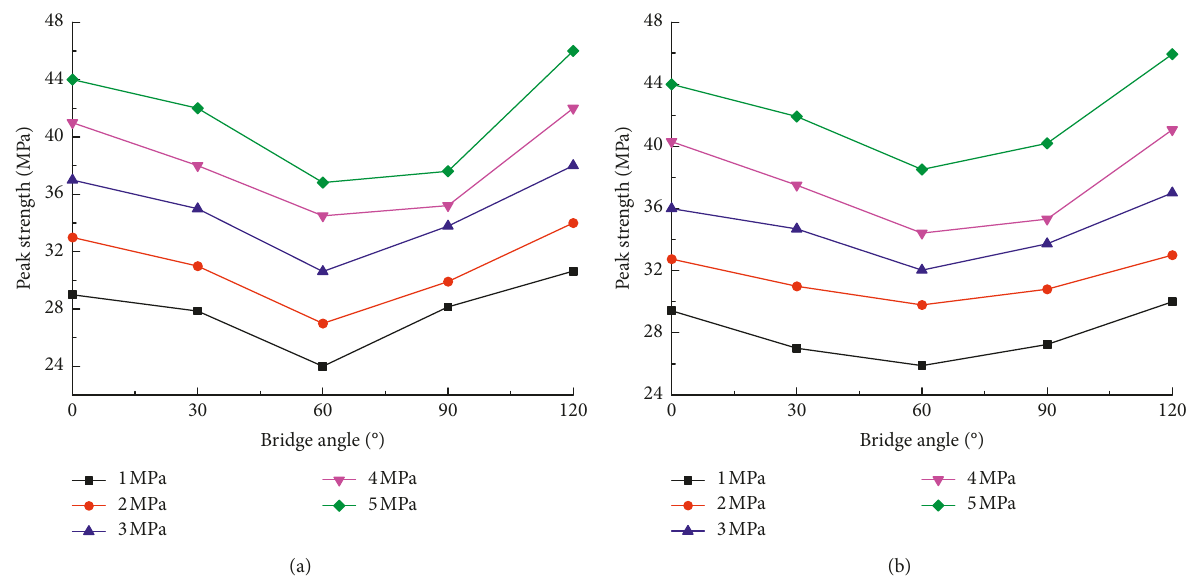
Figure 13: Peak strength of the specimens (a) 20-0-60- β and (b) 20-30-60- β having different bridge angles.